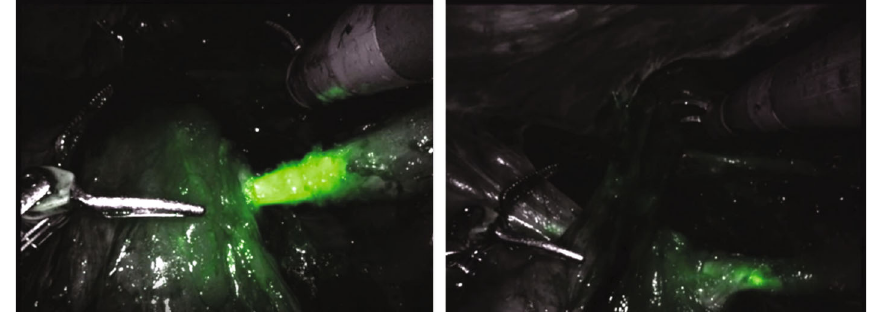
Figure 3: View of the ureter entering the ileal conduit after injection of indocyanine green